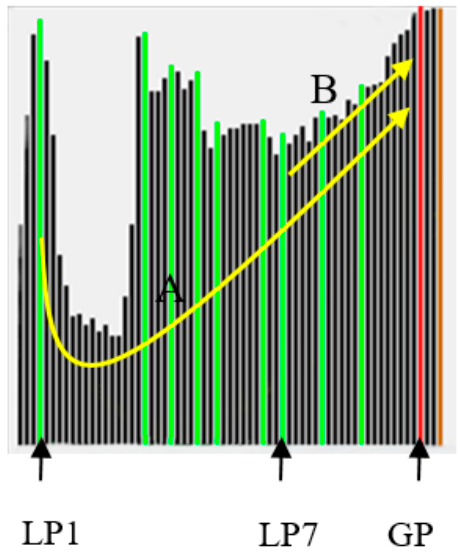
Figure 7. The measure of curve convexity / concavity for each peak LP j , with respect to the global peak GP . (T1) The first test is to calculate the second derivative of FP s and count the number of zero-crossings (ZC). For SP curves, the ZC is normally 4 and the positive and the negative parts have similar